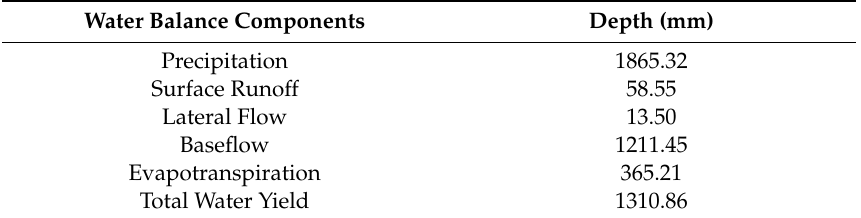
Table 8. Mean annual (1991–2001) water balance components for the entire watershed.